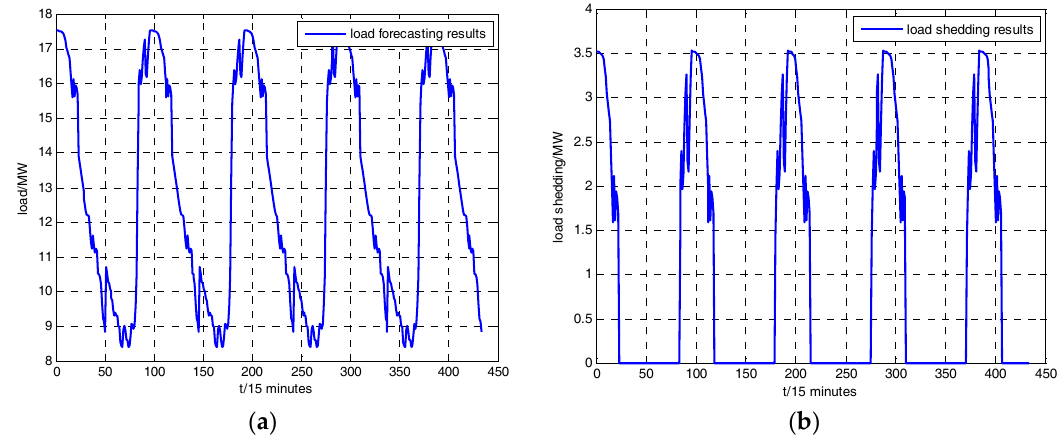
Figure 7. Simulation results of bus 17 at 19:00 ( a ) Load forecasting results of bus 17; ( b ) Load shedding results of bus 17.